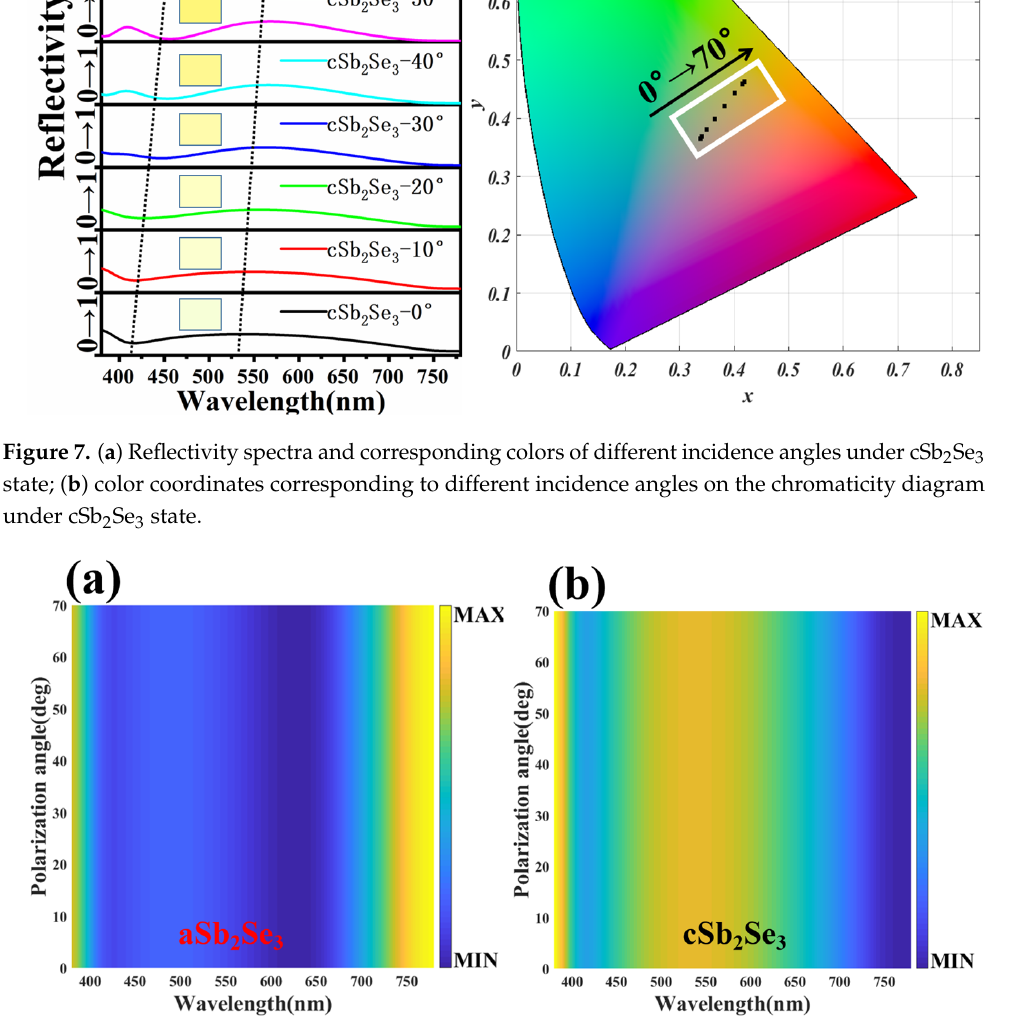
Figure 8. Polarization spectra under aSb 2 Se 3 ( a ) and cSb 2 Se 3 ( b ) states. The geometrical parameters of the structure are critical to the performance. Different